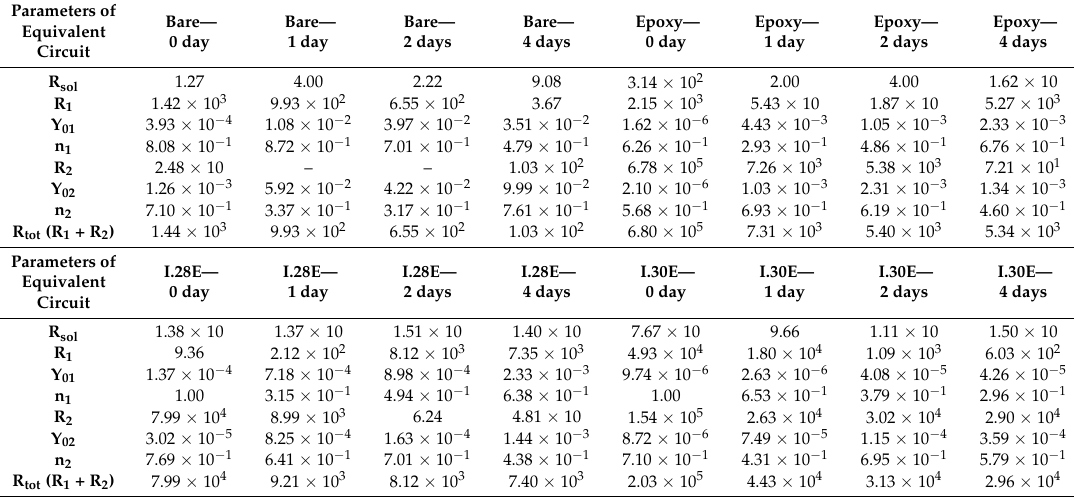
Table 4. Resistance values ( Ω cm 2 ) for bare and coated